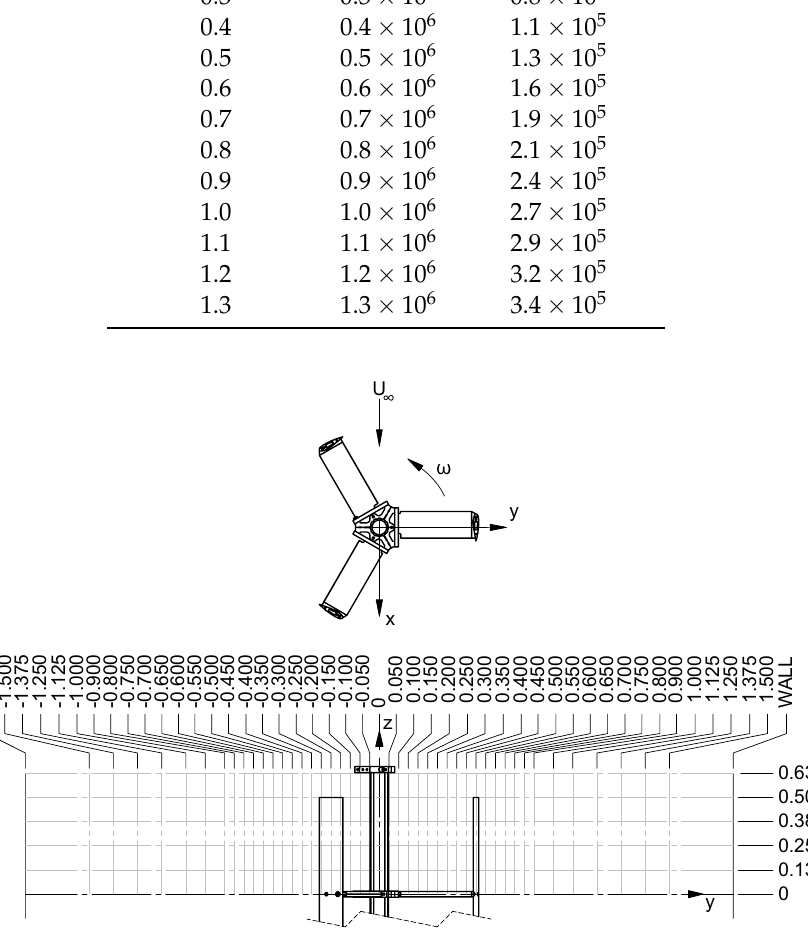
Figure 3. Wake measurement coordinate system and locations. Dimensions are in